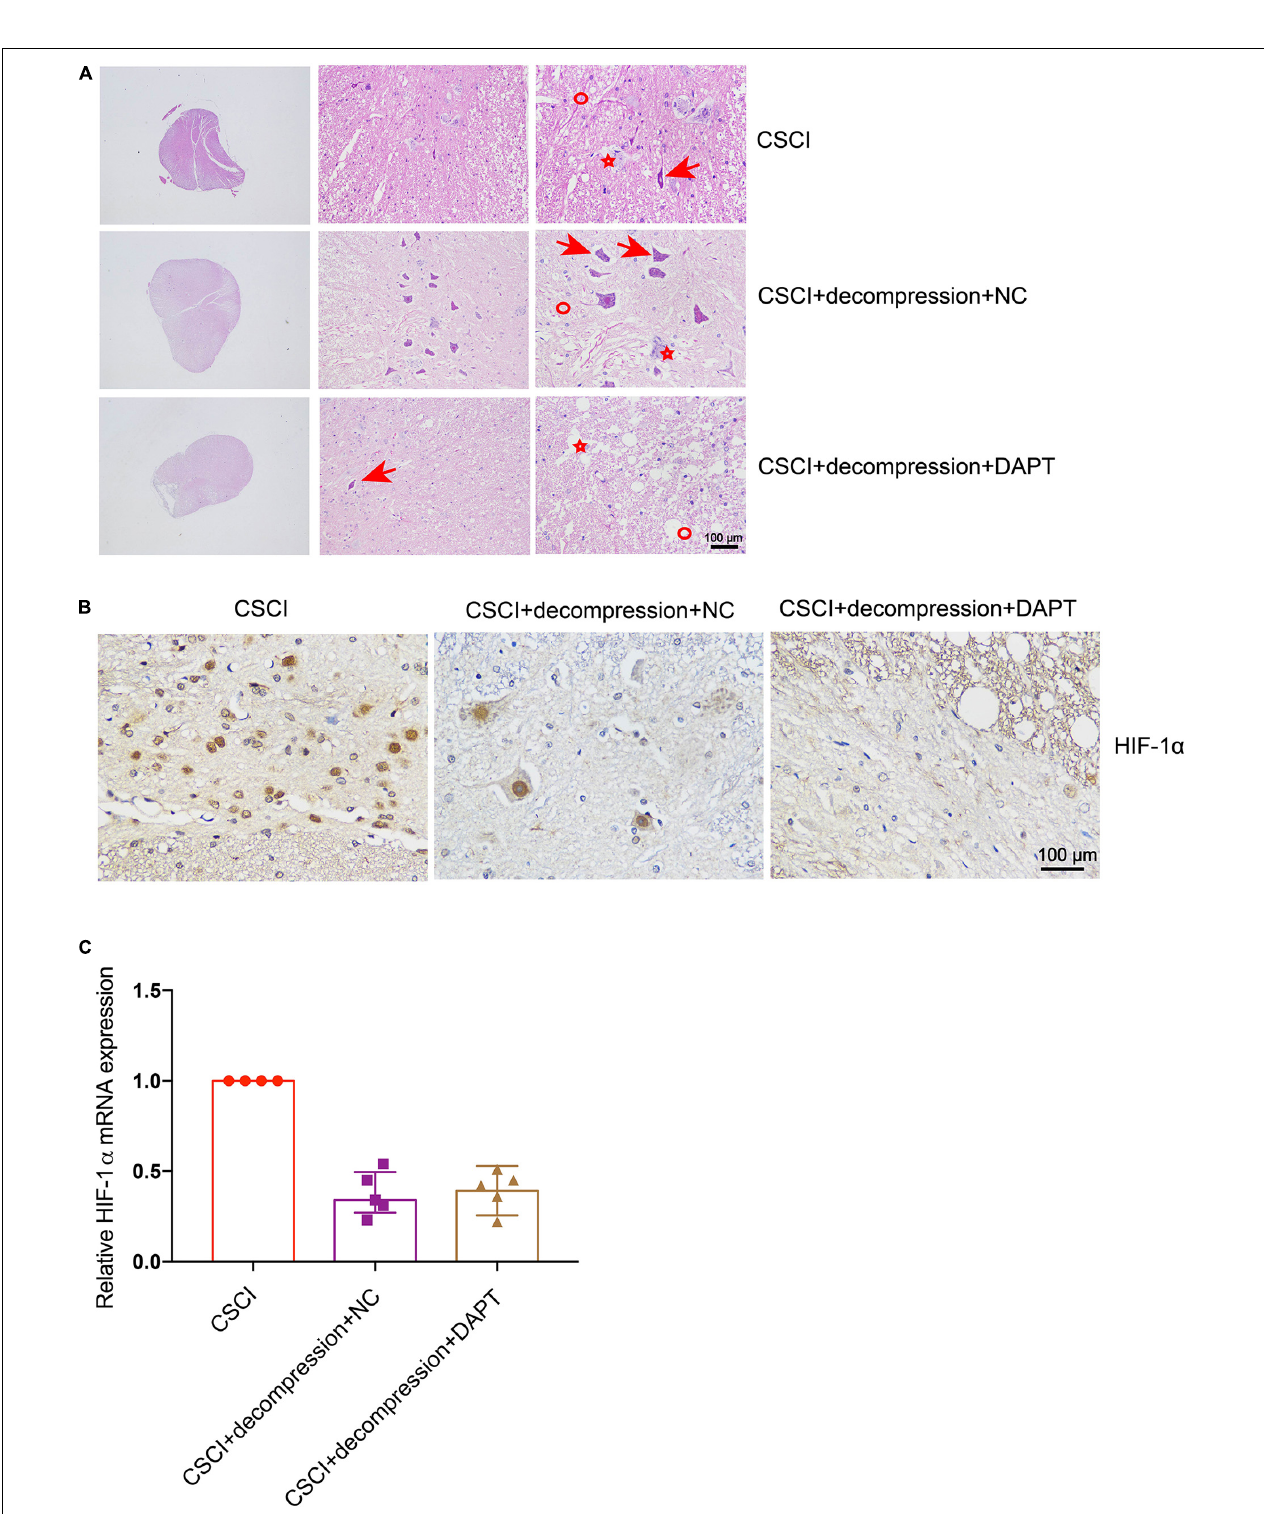
FIGURE 7 | Inhibition of Notch-1 does not have neuron-protective effects on CSCI after decompression. (A) HE staining of lesion sites from the CSCI, CSCI with decompression and NC, and CSCI with decompression and DAPT groups (20 × , 200 × , and 400 × magnification; scale bar, 100 µ m). (B) HIF-1 α expression was assessed by IHC (400 × magnification; scale bar, 100 µ m). (C) The relative HIF-1 α expression was assessed by RT-qPCR. HE staining and IHC: n = 6 each group; RT-qPCR: the CSCI group: n = 4; CSCI with decompression and NC group: n = 5; CSCI with decompression and DAPT group: n = 5; Medians ± interquartile ranges, the sample size was too low to perform statistics for these